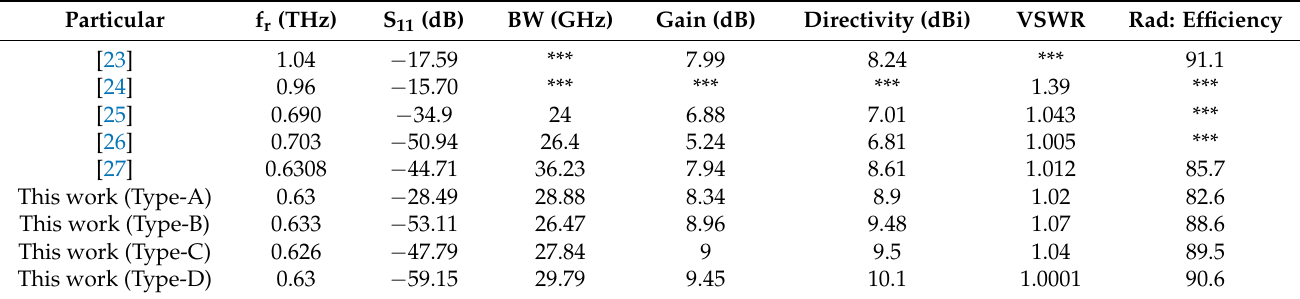
Table 3. Comparison of the proposed antenna with sate of the art